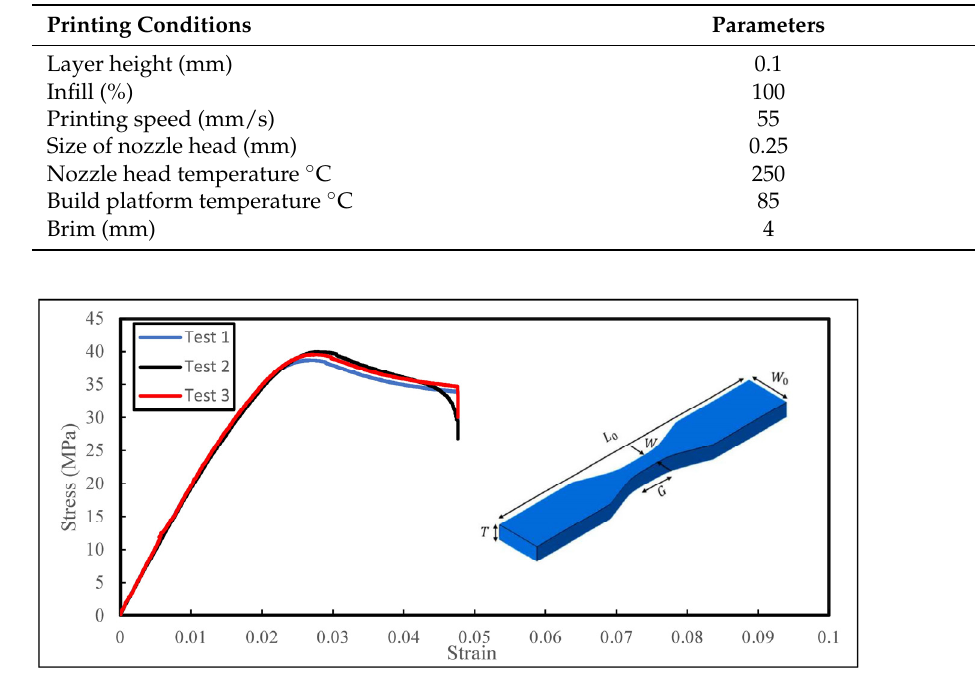
Figure 3. Stress–strain curves of 3D-printed tensile samples. Table 3. Dimensions of tensile samples (units: mm).